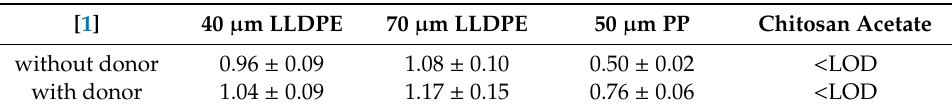
Table 1. Overall migration for barrier films without donor (intrinsic; representing polyolefin oligomeric saturated hydrocarbons (POSH)) and films with donor (POSH + mineral oil saturated and aromatic hydrocarbons (MOSH / MOAH)). Values normalized to the values of the donor (migration of donor = 1). Limit of detection (LOD) = 0.15. n = 3.